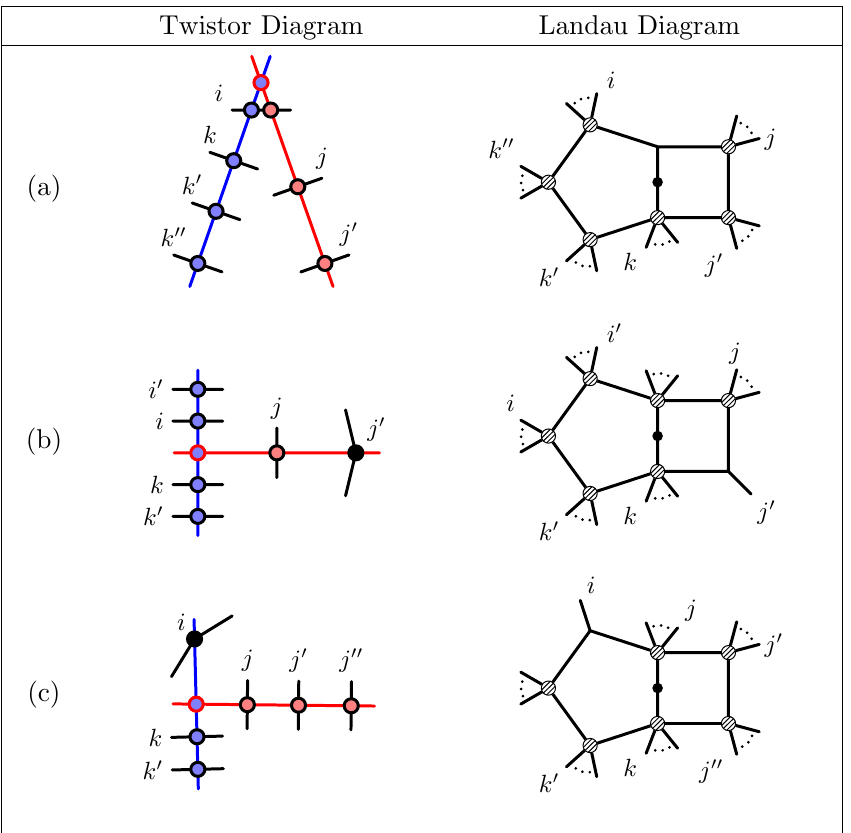
Table 4 . The twistor and Landau diagrams describing types of maximal codimension boundaries of N k (cid:21) 3 MHV